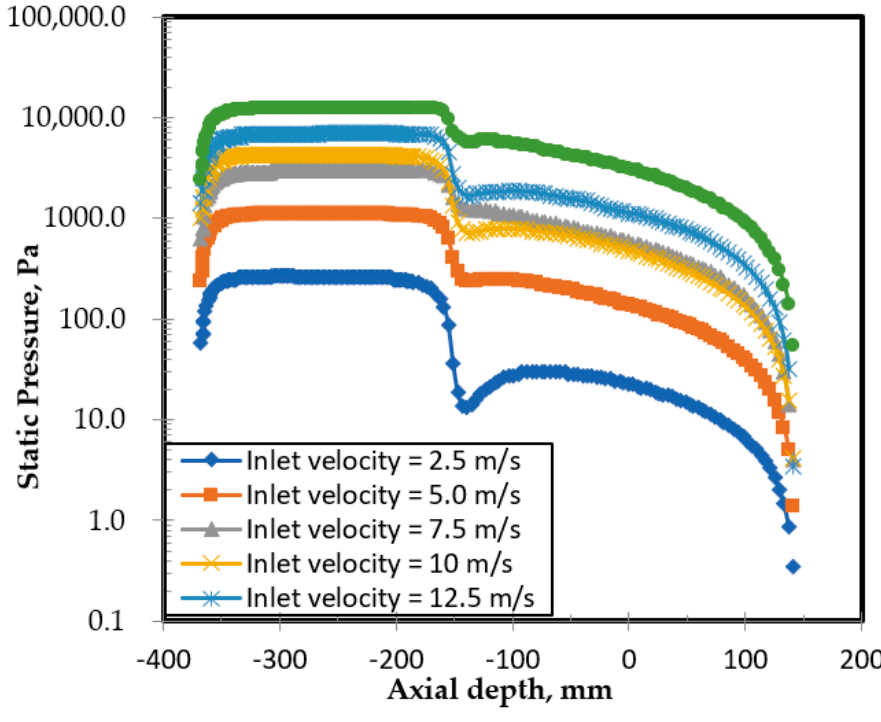
Figure 11. Static pressure distribution with the increasing axial depth in the plane y = 0 mm inside the TPHS under different inlet